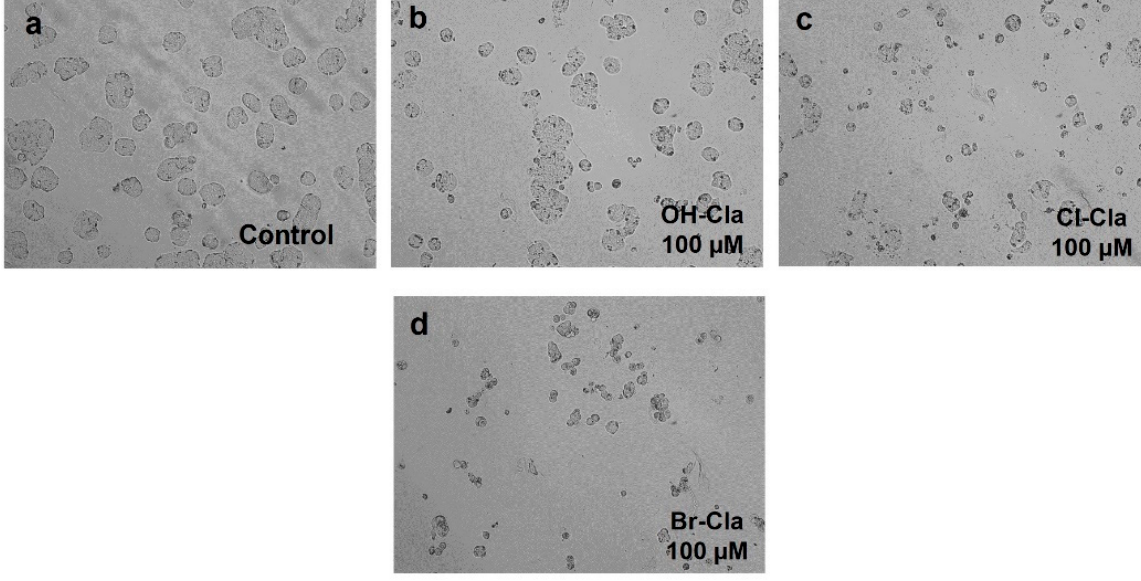
Figure 5. Microscopic cellular visualization of HT-29 cells after 48 h of incubation with cell medium and ( a ) 0.1% DMSO (control), ( b ) OH-Cla, ( c ), Cl-Cla, or ( d ) Br-Cla. Representative images were obtained with a high contrast brightfield objective (10×) (LionHeart FX Automated Microscope), from three independent experiments.